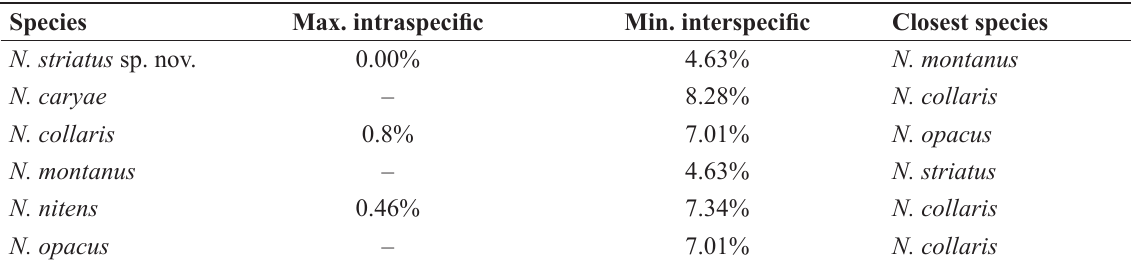
Table 1. Uncorrected pairwise distances of species of Neoxorides Clément,